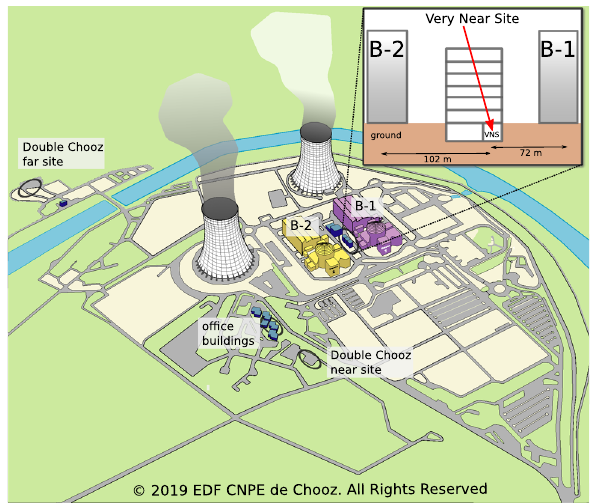
Fig. 2 Sketch of the Chooz nuclear power plant and of the Very-Near- Site (VNS). The VNS is located in-between the two reactor buildings B-1 and B-2. Since 2008, the power plant hosts the Double Chooz experiment with two experimental sites, denoted the near and the far site. Office buildings close to the Double Chooz sites can be used in the future. The inset on the top right shows the office building between the reactor cores hosting the VNS. Figure credit to EDF CNPE de Chooz